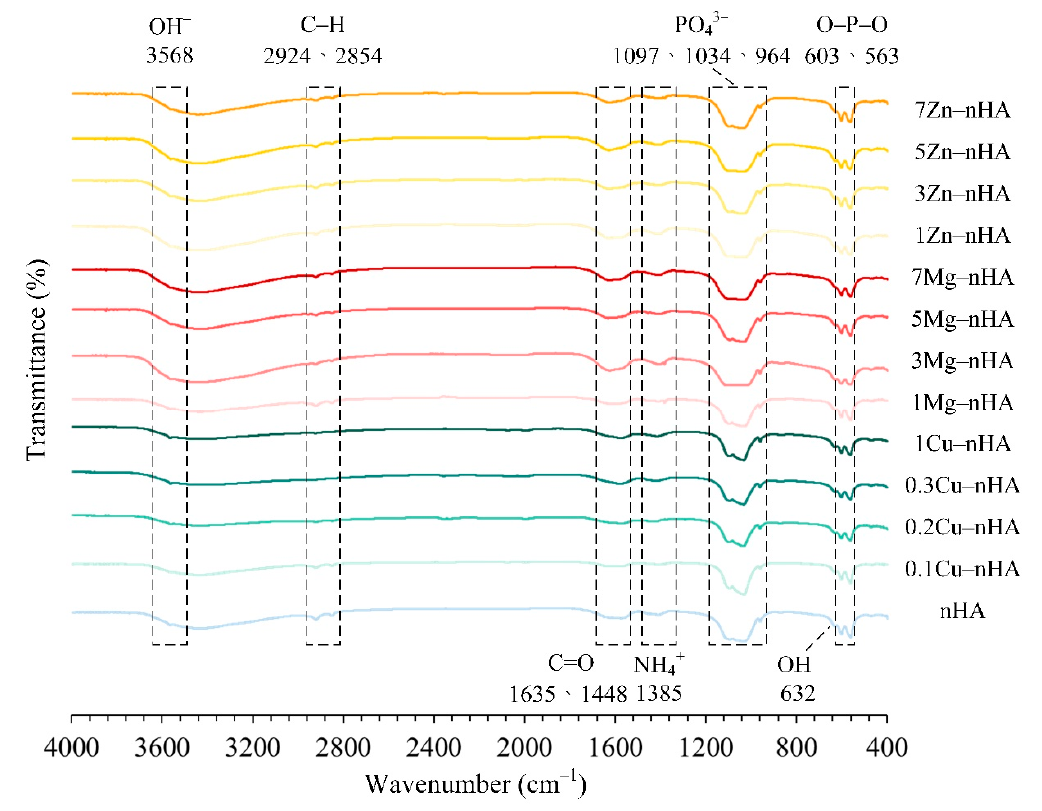
Figure 1. Fourier transform infrared spectra of rod-shaped nanoapatites synthesized with and without Cu 2+ , Mg 2+ , and Zn 2+ at different ion concentrations.